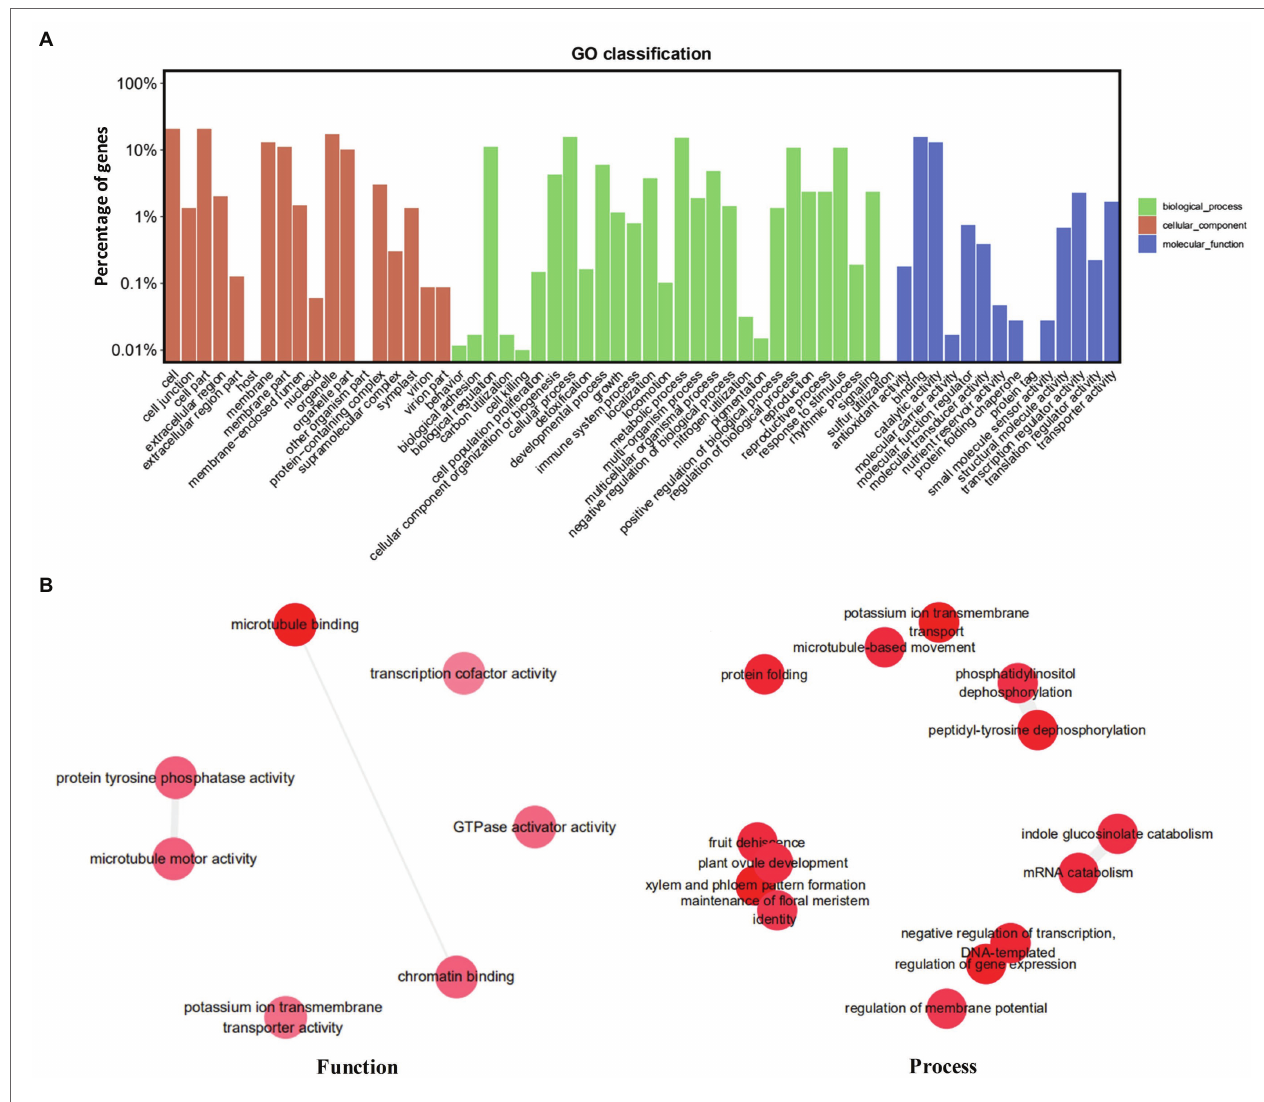
FIGURE 6 | Functional analysis (gene ontology) of cabbage genes containing SSRs. (A) GO classification. (B) Revigo summary of “biological process” and “molecular function” enriched